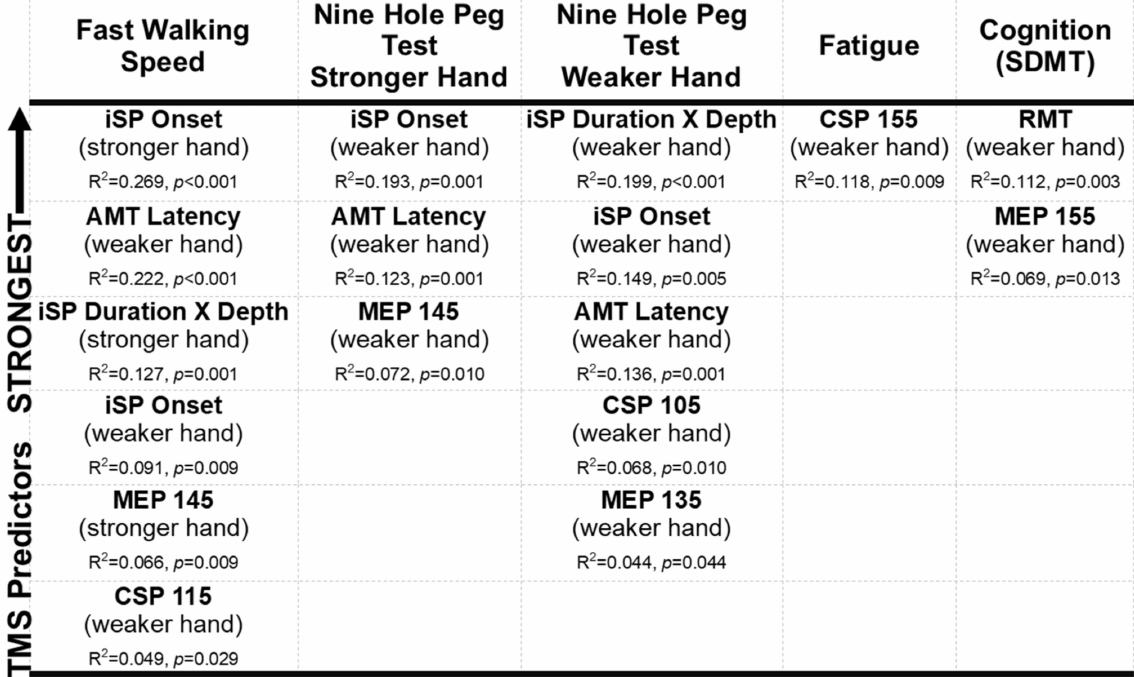
Figure 10. Transcranial magnetic stimulation (TMS) Variables that Most Strongly Predict Clinical Outcomes. AMT, active motor threshold; CSP, cortical silent period; iSP, ipsilateral silent period; MEP, motor evoked potential; RMT, resting motor threshold; SDMT, symbol digit modality